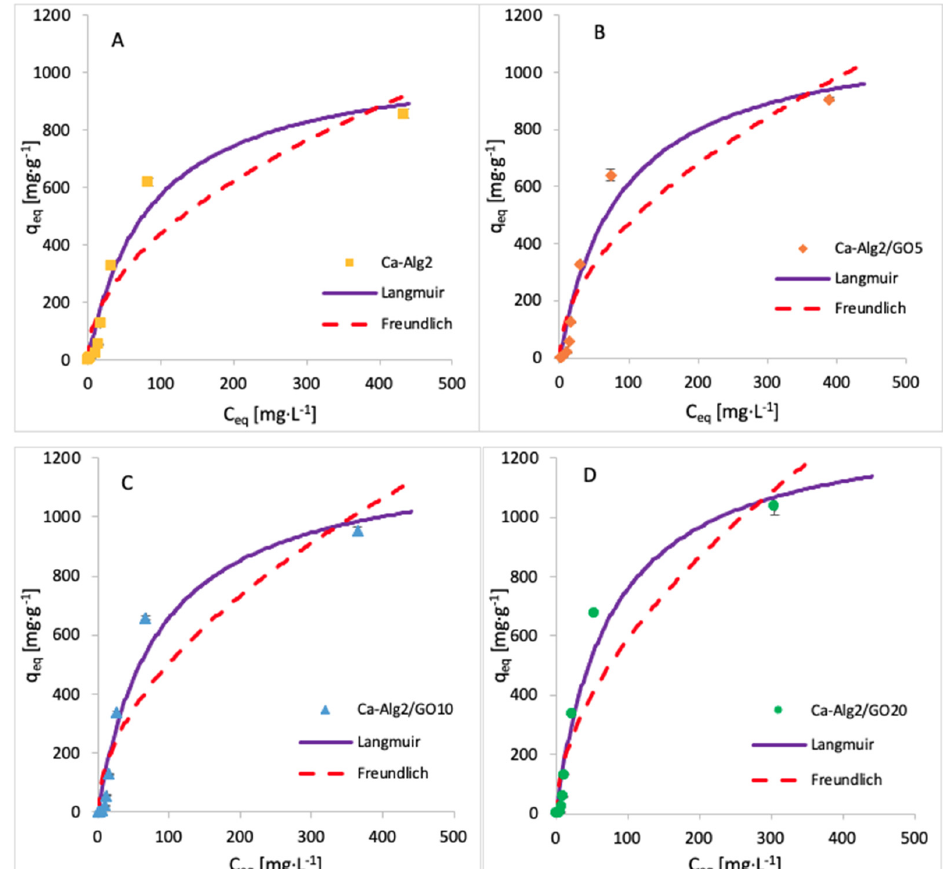
Figure 13. Adsorption isotherms for MB using ( A ) Ca-Alg2, ( B ) Ca-Alg2/GO5, ( C ) Ca-Alg2/GO10 and ( D ) Ca-Alg2/GO20 dried beads. Table 7. Langmuir and Freundlich isotherm constants for MB adsorption onto Ca-Alg2 and Ca-Alg2/GO beads.